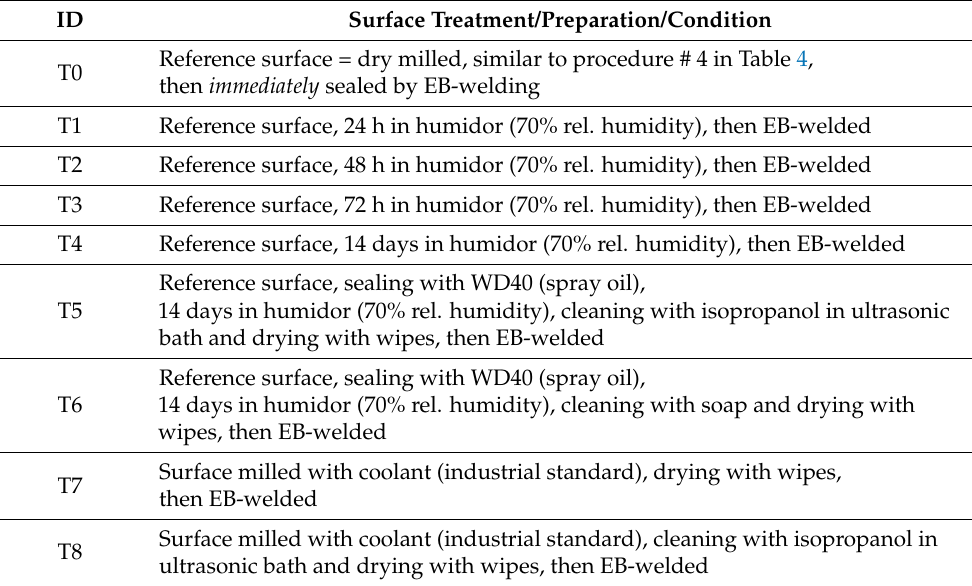
Table 5. Preparation and fabrication details of the surface contamination study. The different surface treatments are denoted as